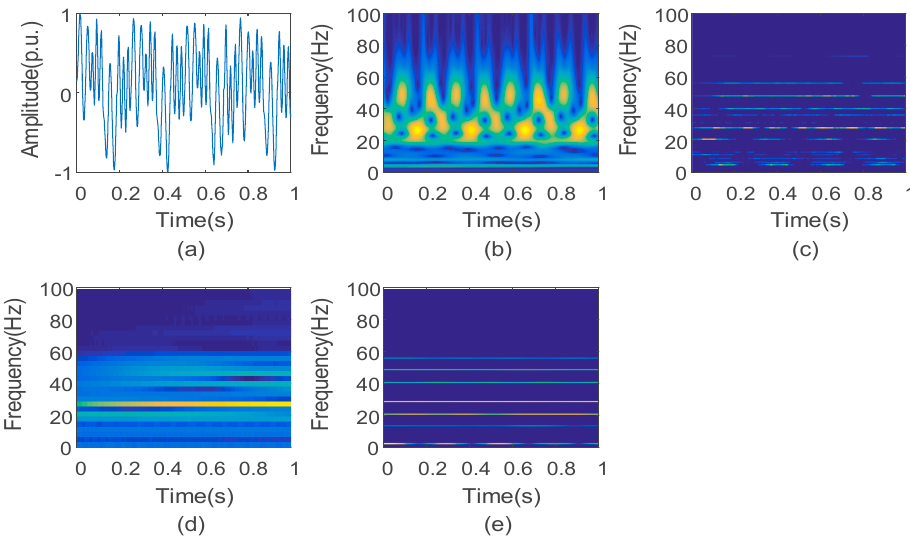
Figure 10. Simulation comparison of the output current signal of the induction motor based on the inverter power supply. ( a ) The original signal, ( b ) time-frequency diagram of ST, ( c ) time-frequency diagram of SSTFT, ( d ) time-frequency diagram of WT, ( e ) time-frequency diagram of SAST.